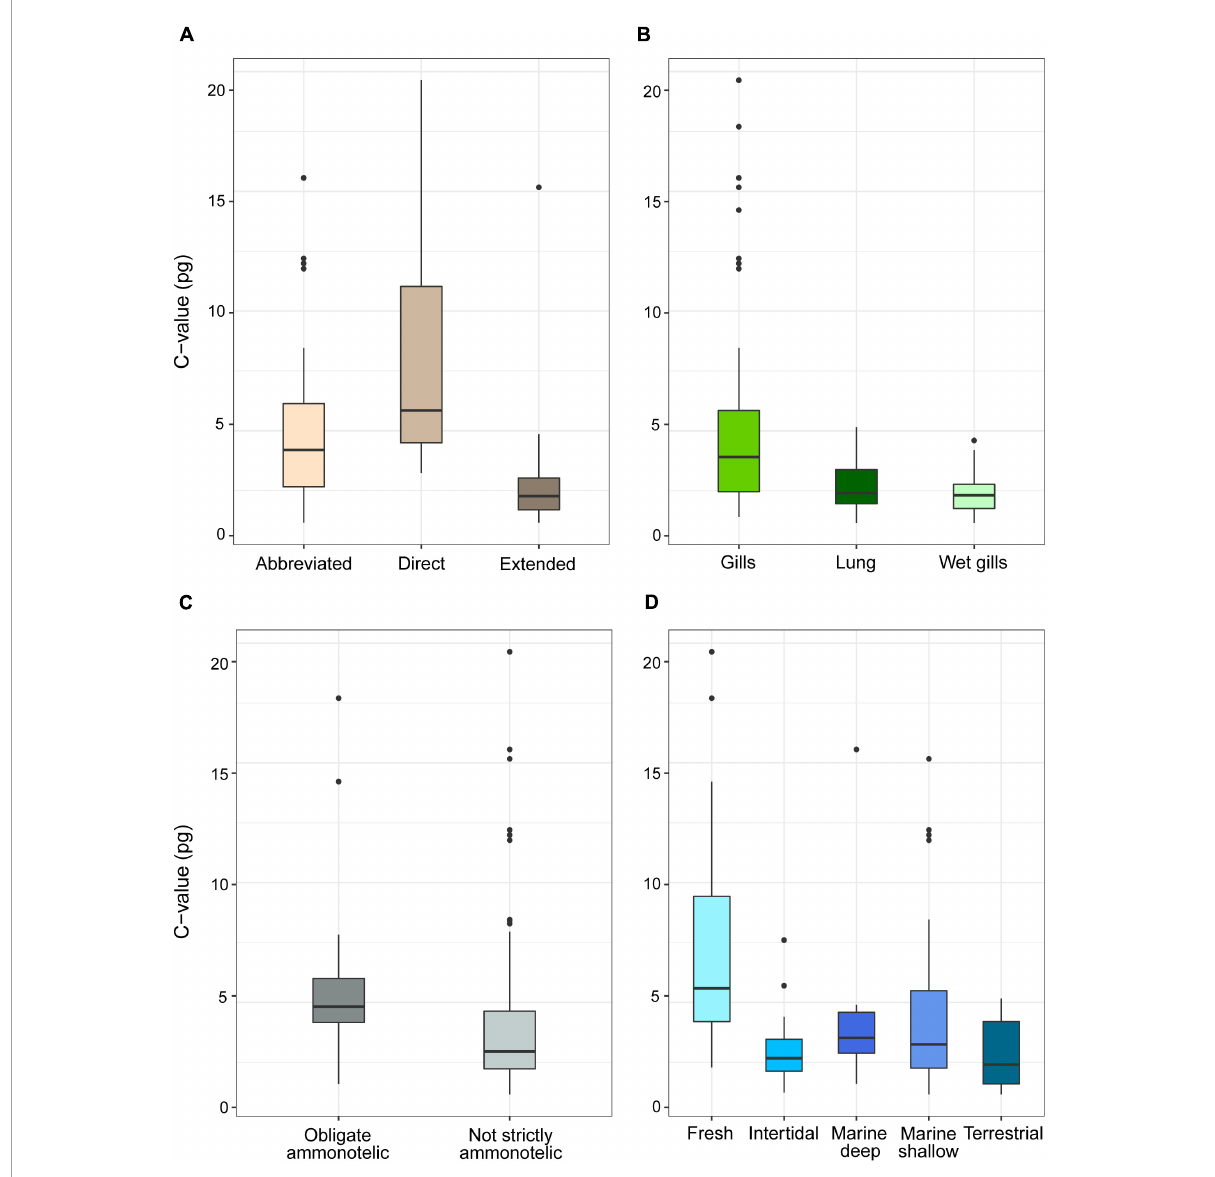
FIGURE4 Genome size (pg, uncorrected values) in species of decapods belonging to the infraorders Anomura, Astacidea and Brachyura grouped according to developmental (A) , respiration (B) , excretion (C) mode, and habitat (D) . The boxplots whiskers indicate the 95% confidence intervals and the dots indicate the